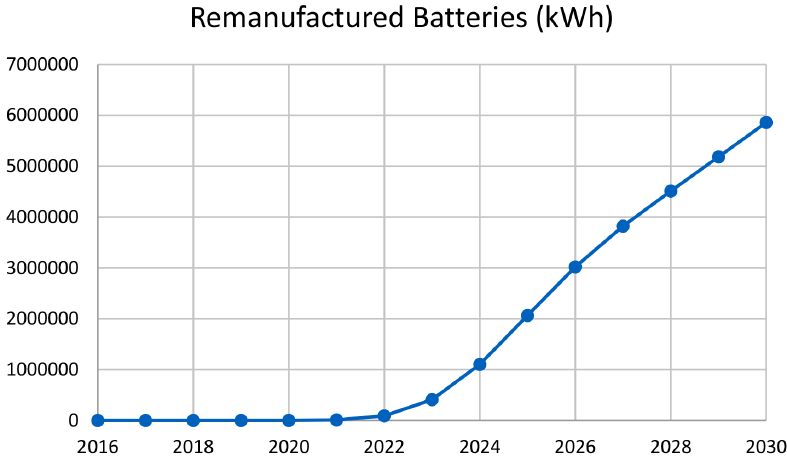
Figure 1. Remanufactured Battery Capacity (kWh) over Time (Percent remanufactured =